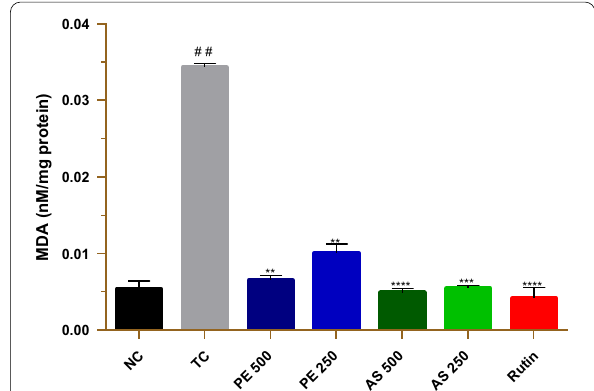
Fig. 2 Effect of P. erinaceus and A. spinosus in MDA levels in lenses. NC normal control under 5.5 mM glucose; TC toxic control under = = 55 mM glucose; PE and AS 500; 250 P. erinaceus and A. spinosus at = doses of 500 and 250 mg/kg bw 55 mM glucose; Rutin rutin at a + = dose of 500 µg/kg bw 55 mM glucose. The values were analyzed + with a one‑way ANOVA and then expressed as mean SEM. ## p < 0.01 ± compared to NC; ** p < 0.01; **** p < 0.0001, compared to TC. n =